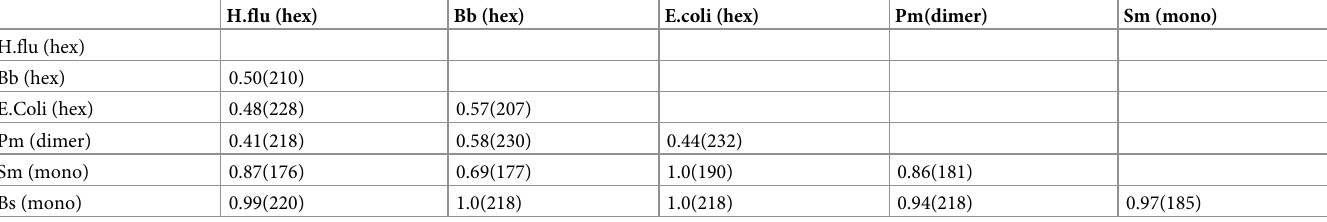
Table 2. Superposition of the C-alpha atoms of monomers of the different bacterial NagBs whose structures have been determined. The RMS deviations are in Å units. The numbers in the parenthesis are the number of C-alpha atoms that were superposed. Superposition was carried out using the ‘super’ command in Pymol. The two monomeric proteins have a C-terminal helix missing. Hex- in the names corresponds to proteins that are hexamers, and mono- for those that are